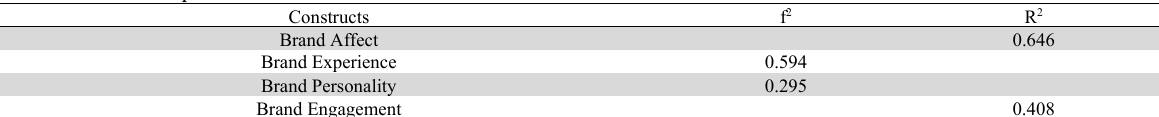
Effect Size and R Square